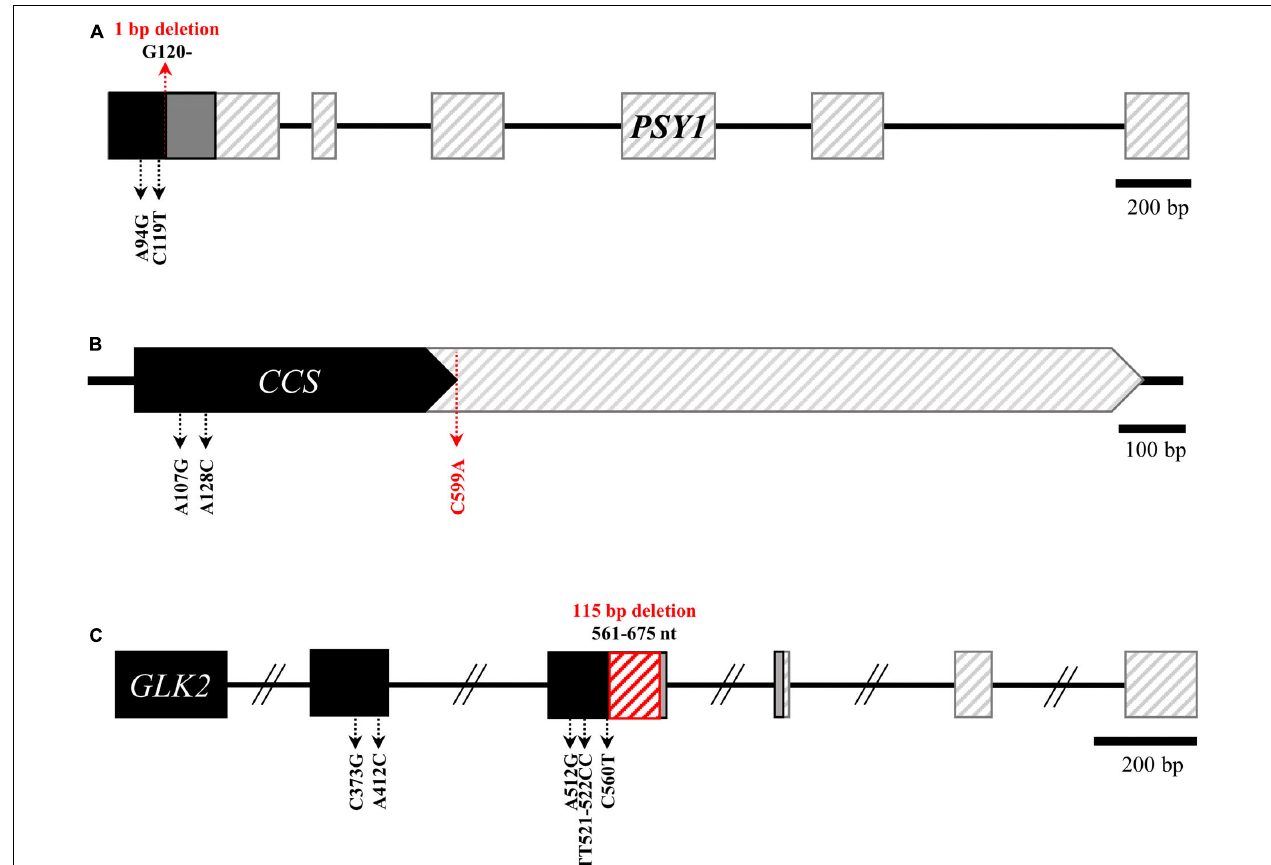
FIGURE 2 | Common background mutations in PSY1 , CCS , and GLK2 of AC08-045 and AC08-201. (A–C) Common mutations in the genes PSY1 , CCS , and GLK2 of AC08. In alleles with early stop codons, non-synonymous mutations downstream from those stop codons are omitted. Major mutation of each gene are highlighted in red letters. Black region indicates normal transcription, and gray regions indicate frameshifted regions. Regions after early translation termination are indicated with diagonal lines. The 115-bp deletion in GLK2 is indicated with red diagonal